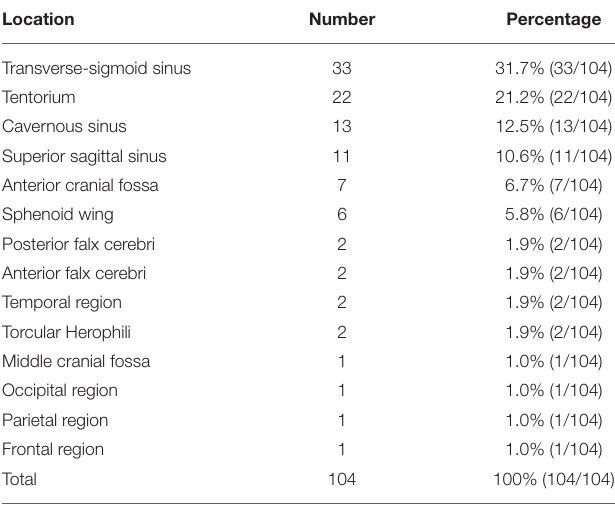
TABLE 1 | Locations of dural arteriovenous fistulas.